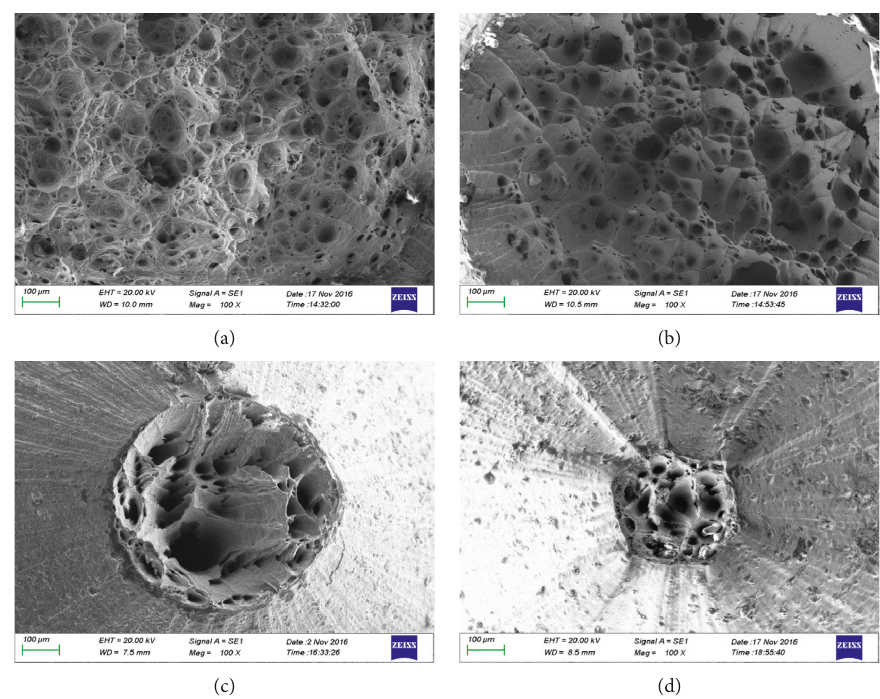
Figure 13: The fracture morphology of samples with notch radius of 2mm at different temperatures: (a) 850 ° C, (b) 950 ° C, (c) 1050 ° C, and (d) 1150 ° C.